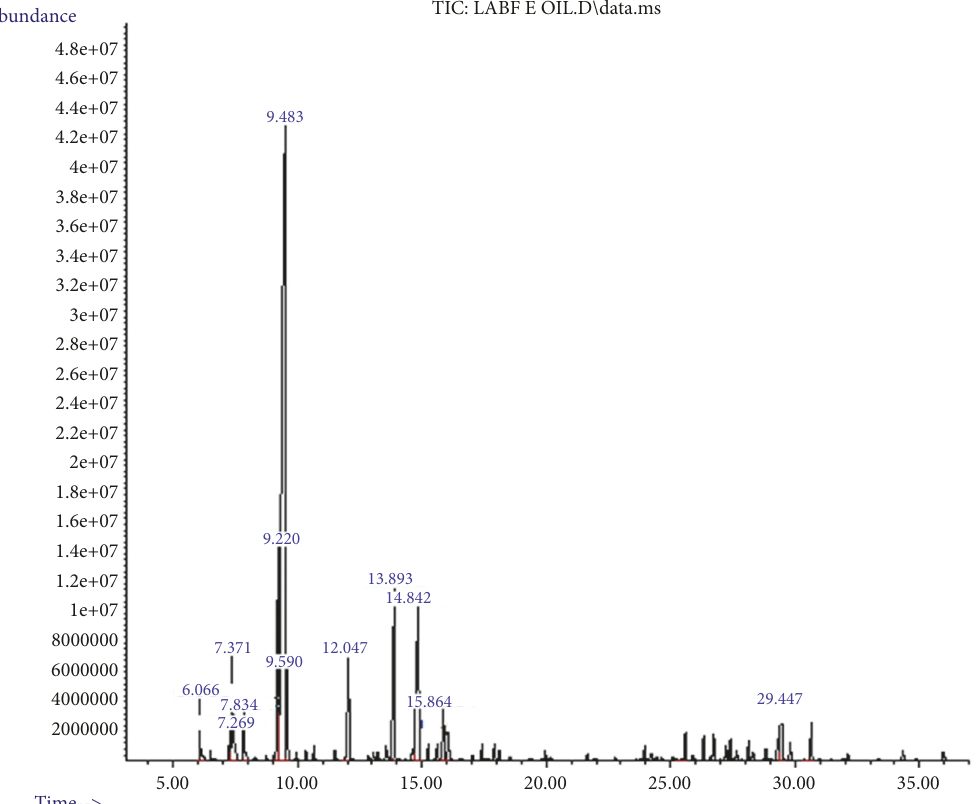
Figure 1: Chromatogram of L. angustifolia essential